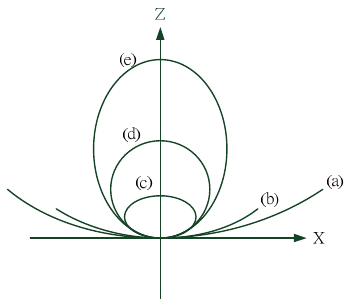
Figure 3. Conic curve. ( a ) K < ´ 1; ( b ) K = 1; ( c ) K > 1; ( d ) K = 0; ( e ) ´ 1 < K < 0. Figure 3. Conic curve. ( a ) K < − 1. ( b ) K = 1. ( c ) K > 1. ( d ) K = 0. ( e ) − 1 < K < 0. Figure 3. Conic curve. ( a ) K < − 1. ( b ) K = 1. ( c ) K > 1. ( d ) K = 0. ( e ) − 1 < K < 0. Figure 3. Conic curve. ( a ) K < − 1. ( b ) K = 1. ( c ) K > 1. ( d ) K = 0. ( e ) − 1 < K < 0.